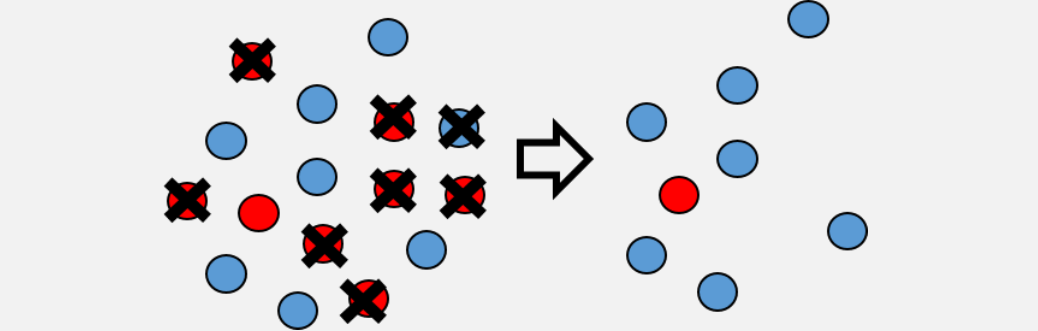
Figure 1. Simplified schematic of host heterogeneity, showing just two types of hosts, high susceptibility (red) and low susceptibility (blue). As the disease spreads, the high susceptibility hosts are infected first, lowering the average susceptibility (and thus the mean transmission ¯ ν ( t ) ) of the